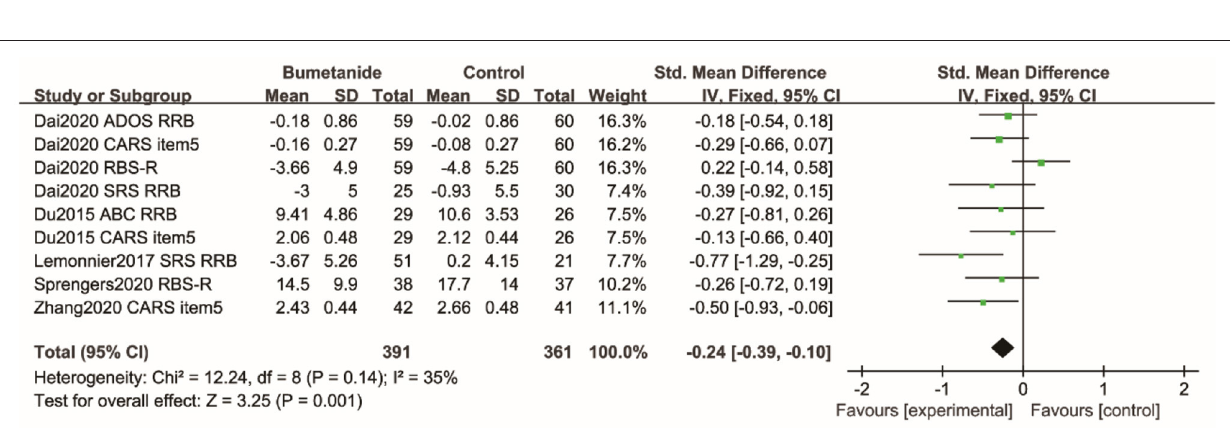
that bumetanide is a safe and tolerated treatment in children with